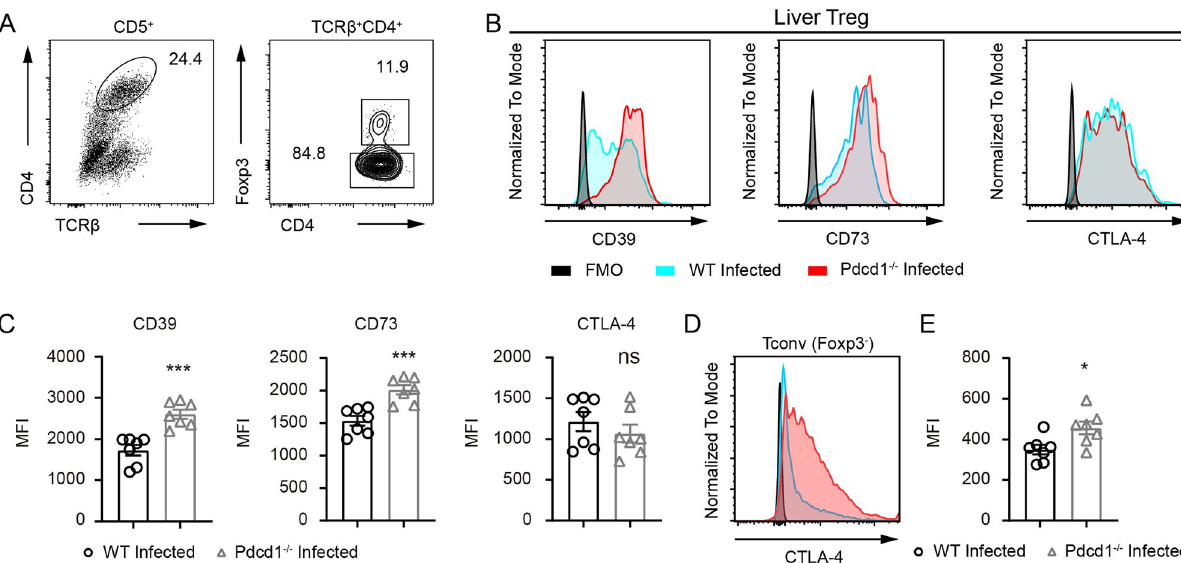
Fig 8. Excessive expression of immunosuppressive receptors by PD-1-deficient regulatory T cells. (A) FACS gating of Foxp3 positive and negative compartments in CD4 + T cells in the livers of WT and PD-1-deficient Pdcd1 −/− mice infected with S . japonicum for 8 weeks. (B-C) Flow cytometric analyses of CD39, CD73 and CTLA-4 in Foxp3 + Tregs in the livers of WT and PD-1-deficient mice infected with S . japonicum for 8 weeks (WT mice, n = 7; KO mice, n = 7). (D-E) Flow cytometric analyses of CTLA-4 in Foxp3 negative conventional CD4 + T cells in the livers of WT and PD-1-deficient mice infected with S . japonicum for 8 weeks (WT mice, n = 7; KO mice, n = 7). Data represent the mean ± s.e.m. Statistical significance was assessed by unpaired Student’s t -test or non-parametric unpaired Mann-Whitney test and indicated by � P < 0.05, ��� P < 0.001, ns, non-significant.